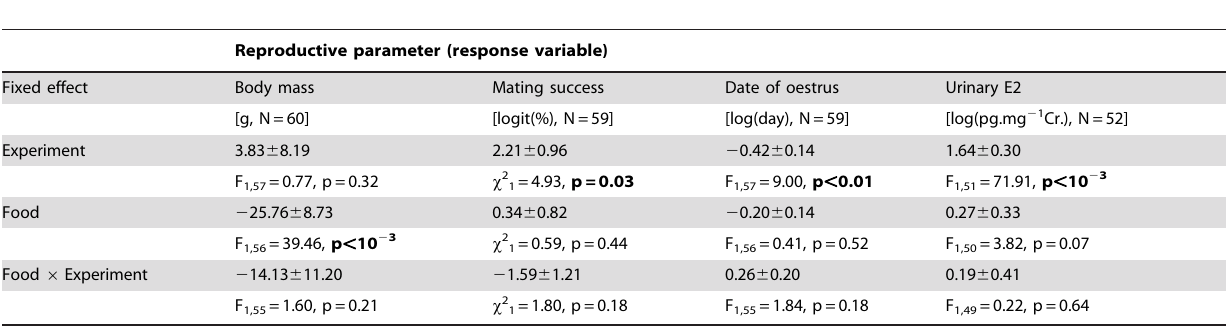
Table 1. Effects of food availability on female condition (body mass), fertility (timing of oestrus, urinary estradiol level at oestrus - noted urinary E2) and mating success.